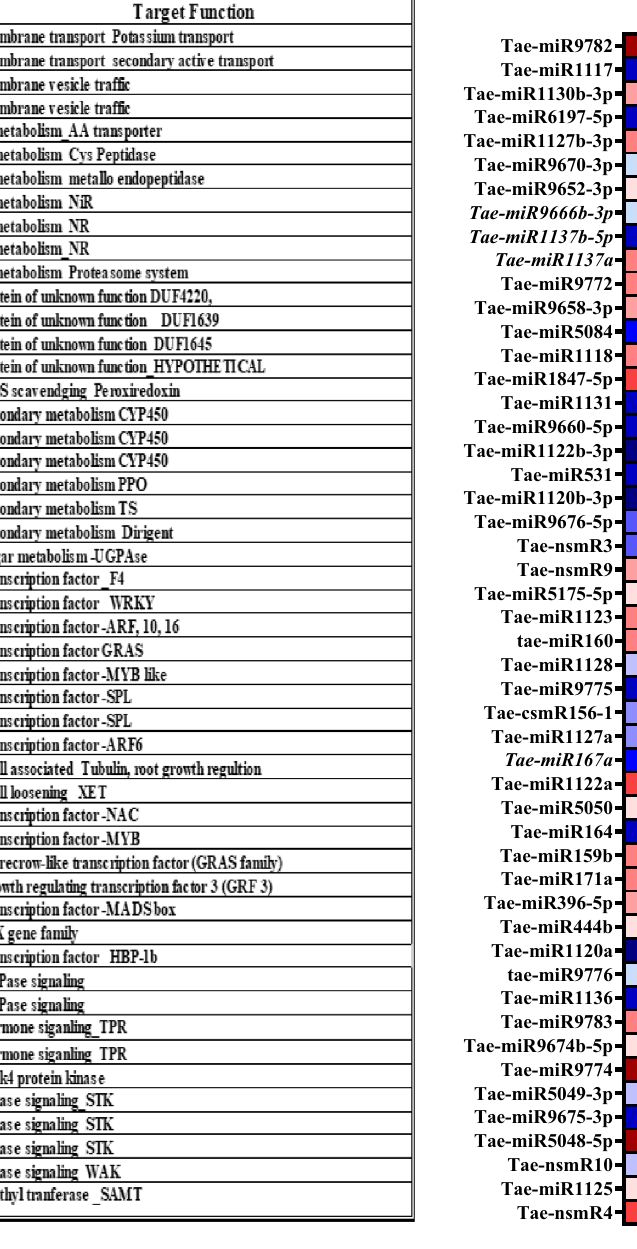
Figure 8. Expression heatmap of differentially expressed miRNA transcripts and the functions of respective target genes from miRNAseq analysis of genotypes BT-Schomburgk (BTS), and T. sph (S3) subjected to control (N+) or N deficient (N−)